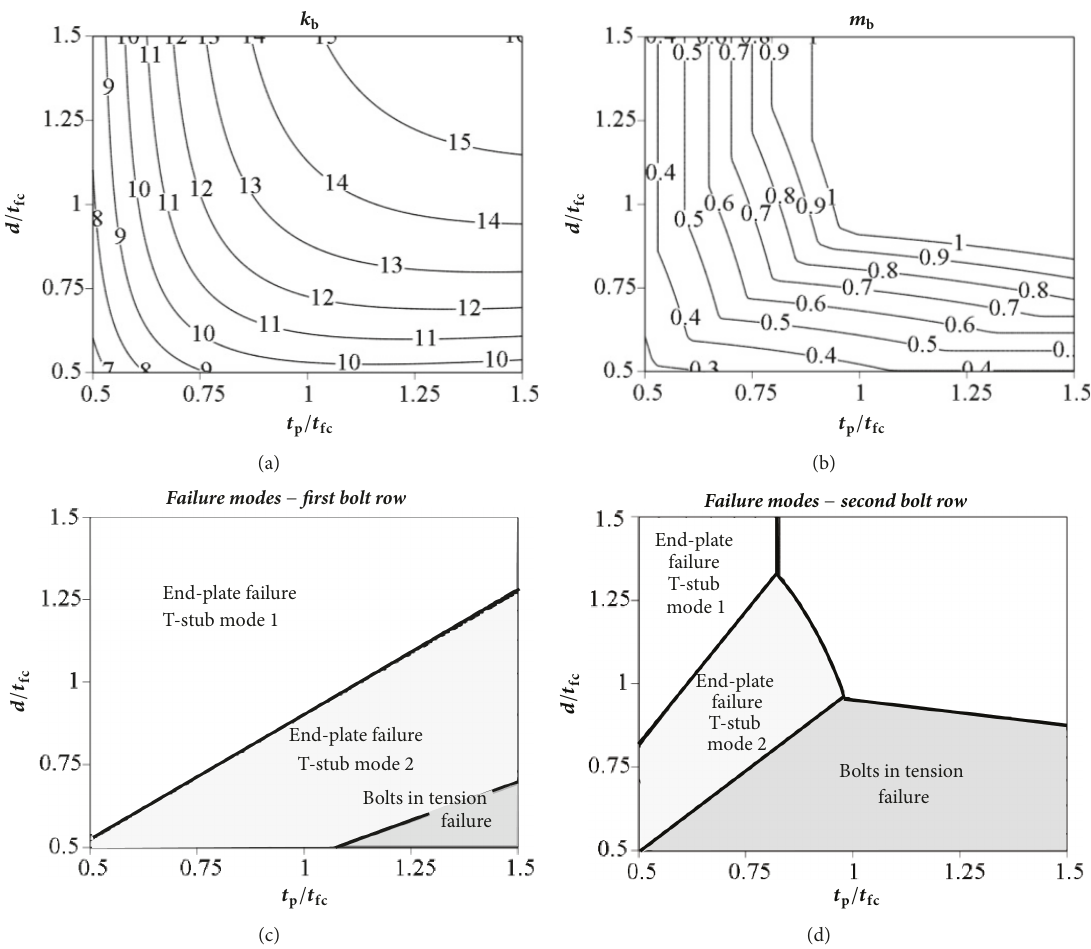
Figure 5: Normalized stiffness (a), normalized resistance (b), and failure modes for the first (c) and the second bolt row (d) of extended end-plate connections (column shape: HEM 280; beam shape: IPE 500; steel grade S275; bolt grade 8.8)